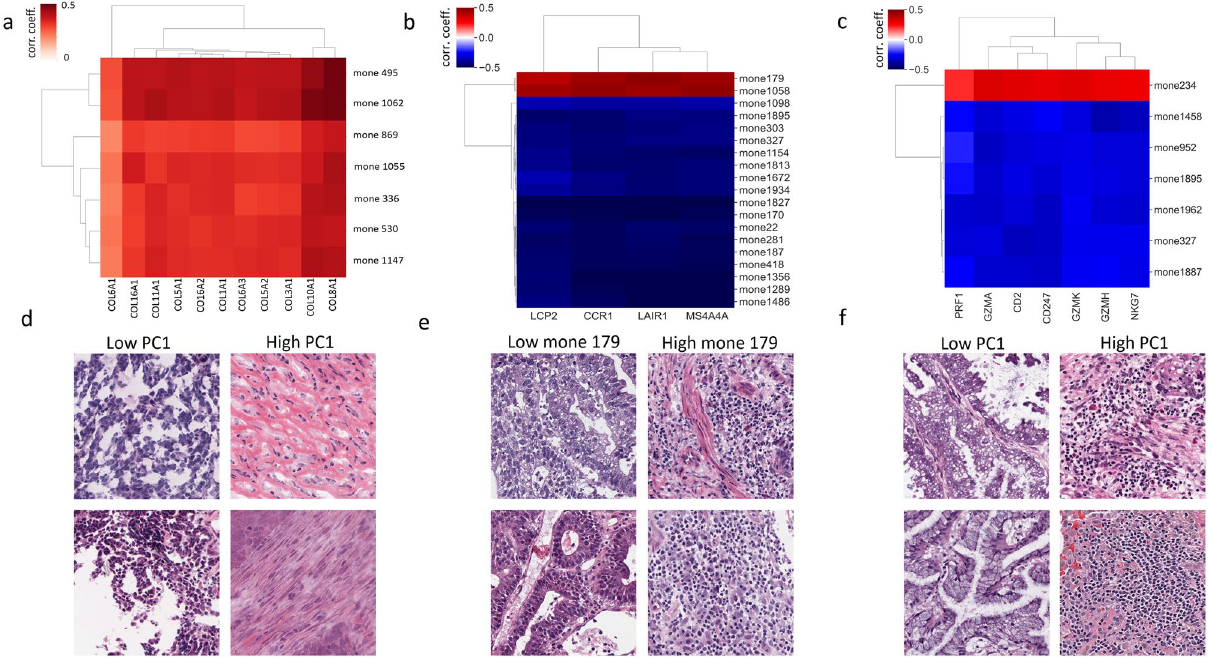
Figure 4. Mone-gene correlation analysis identifies highly correlated mone-gene clusters. Correlation matrix of ( a ) a cluster of highly correlated mones and collagen genes in OV , and a cluster of highly correlated mones and immune-related genes in ( b ) pan-GI cancers and ( c ) LUAD. See Supplementary Fig. 9 for adjusted p-values. Example tiles from slides with ( d ) high and low PC-1 in OV, ( e ) high and low mone 179 in COAD, and ( f )